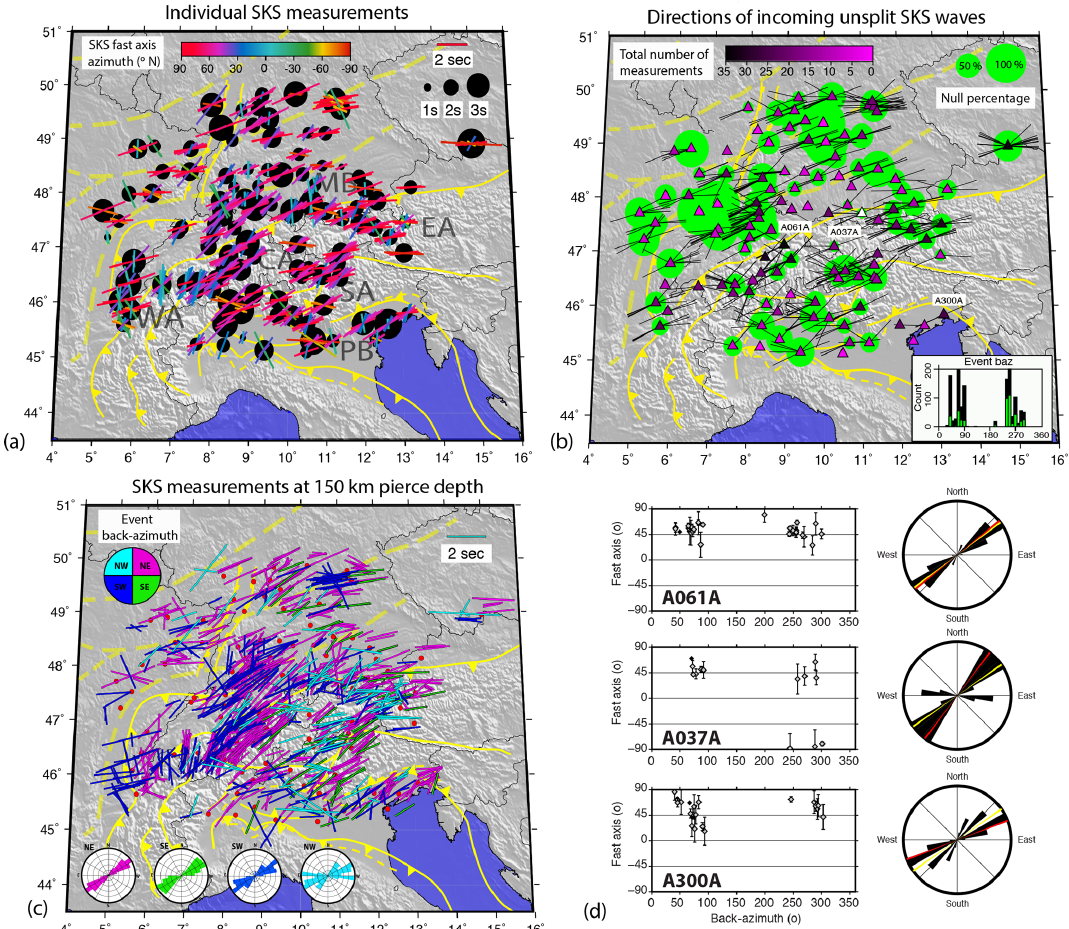
Figure 4. (a) Map of individual SKS fast-axis (bars) and time-delay (black circles) measurements at seismic stations. Colours represent SKS fast-axis back-azimuth. Yellow lines are major tectonic faults. Dashed yellow lines mark the limits of the Molasse and the Po sedimentary basins, respectively. (b) Map of the Alpine region comprising the percentage of null measurements (green circles) from the total number of measurements at each seismic station (coloured triangles). Bars indicate the direction of incoming SKS waves which yielded null mea- surements. Inset: histogram of high-quality earthquakes analysed in this study (black bars) and the number of null measurements (green bars) in 10 ◦ back-azimuthal bins. (c) SKS measurements (bars) coloured with respect to the back-azimuth and shifted to the 150km piercing point. Red points are the stations. Rose diagrams represent polar histograms of the SKS fast-axis directions for earthquakes coming from the NW, NE, SW, and SE, respectively. (d) Results at stations from different regions: A061A (Swiss Alps), A037A (Central Alps), and A300A (eastern Po Basin), also labelled in panel (b) . Left: plots of the SKS fast-axis measurements versus back-azimuth. Right: normalized rose diagrams of SKS fast-axis directions, average SKS direction computed using the circular average (yellow), and the one obtained by stacking misfit surfaces from individual SKS splitting solutions